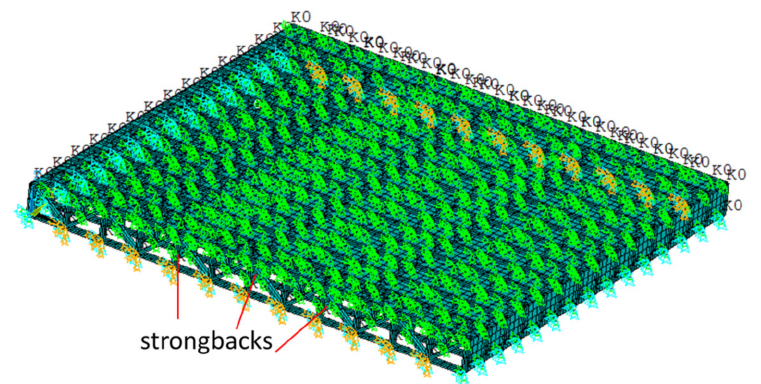
Figure 9. Floor shape model with three rows of strongbacks.